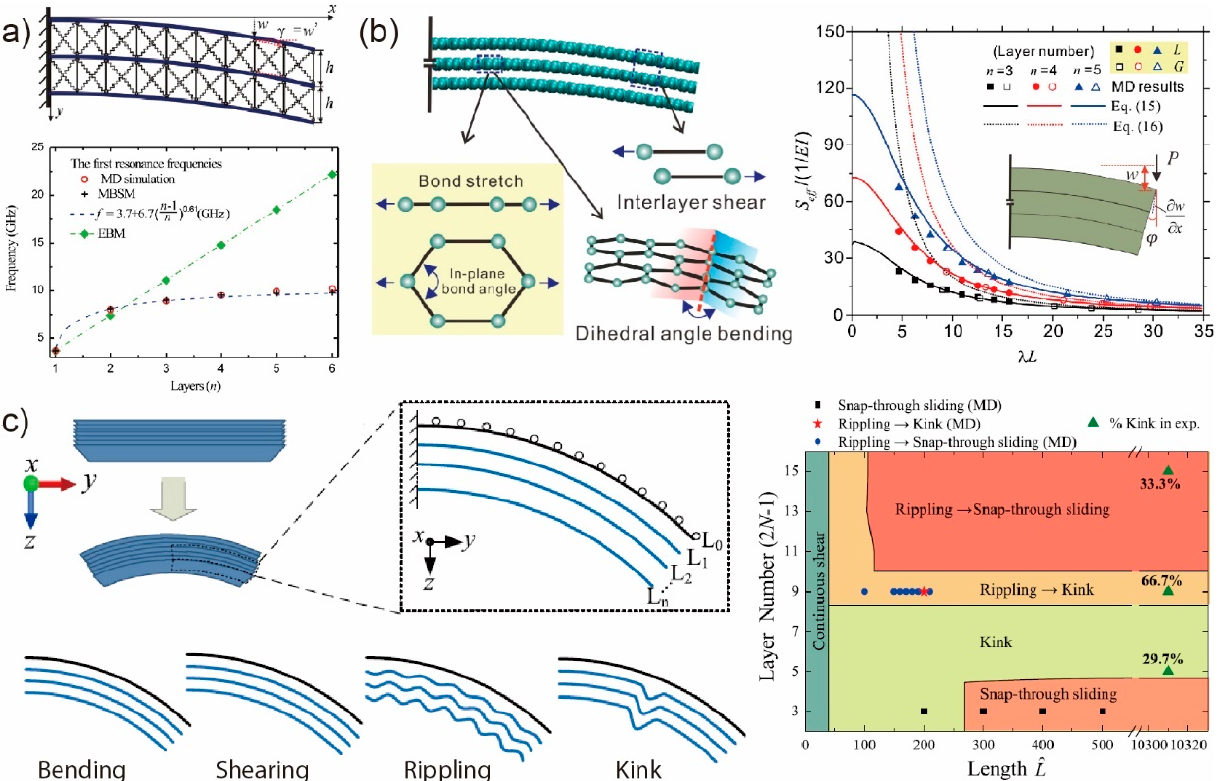
Figure 4. Bending models for laminar structures. ( a ) Multi-beam shear model, the in-plane extension of each sheet is neglected. Reprinted with permission from [78]. ( b ) Modified Timoshenko beam model (MTBM). Reprinted with permission from [31]. ( c ) Failure behaviors of GLNs under bending deformation, including interlayer shearing, rippling, and kink/delamination. Adapted and reprinted with permission from